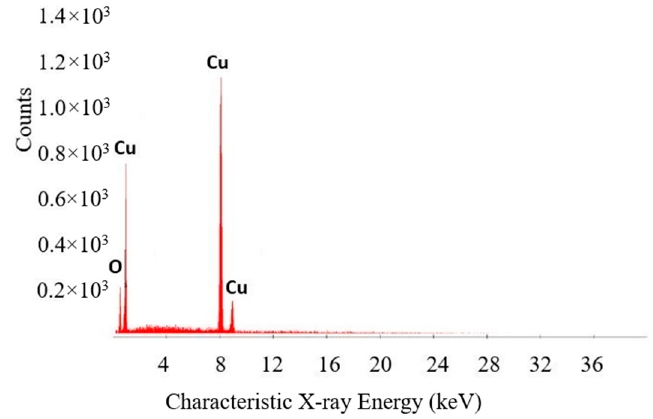
Figure 2. EDX spectrum analysis of the superhydrophobic copper surface.